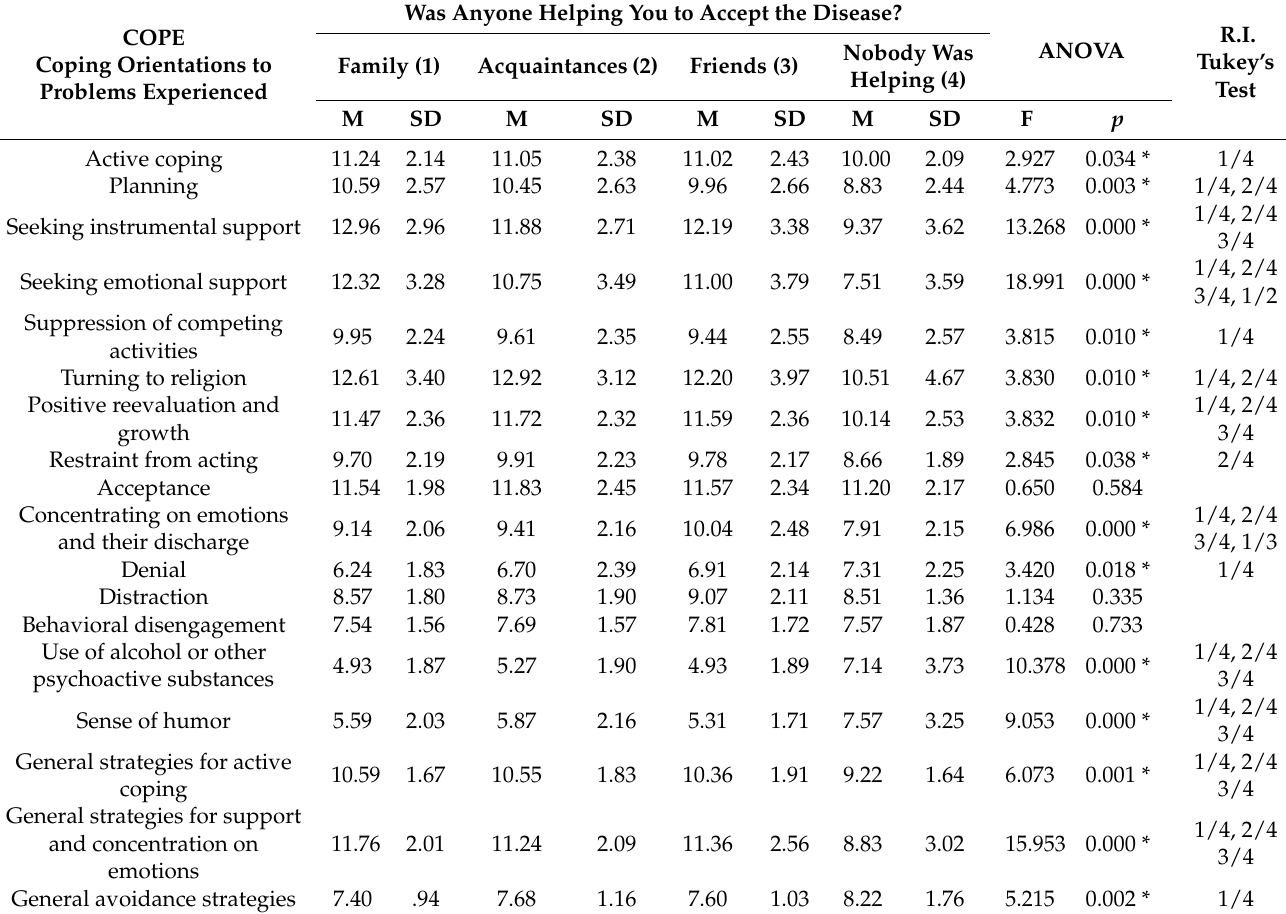
Table 4. People helping in accepting the disease and the strategies of coping with the